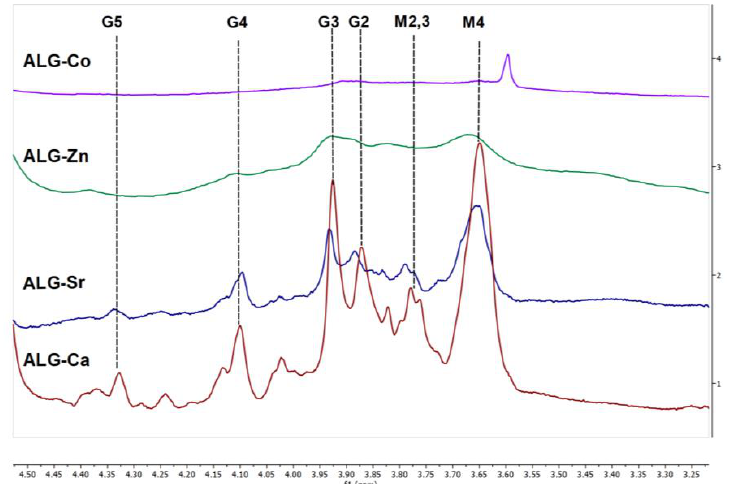
Figure 2. 1 H NMR spectrum of ALG. Fitting is represented by red lines, fitting baseline is shown at the bottom.